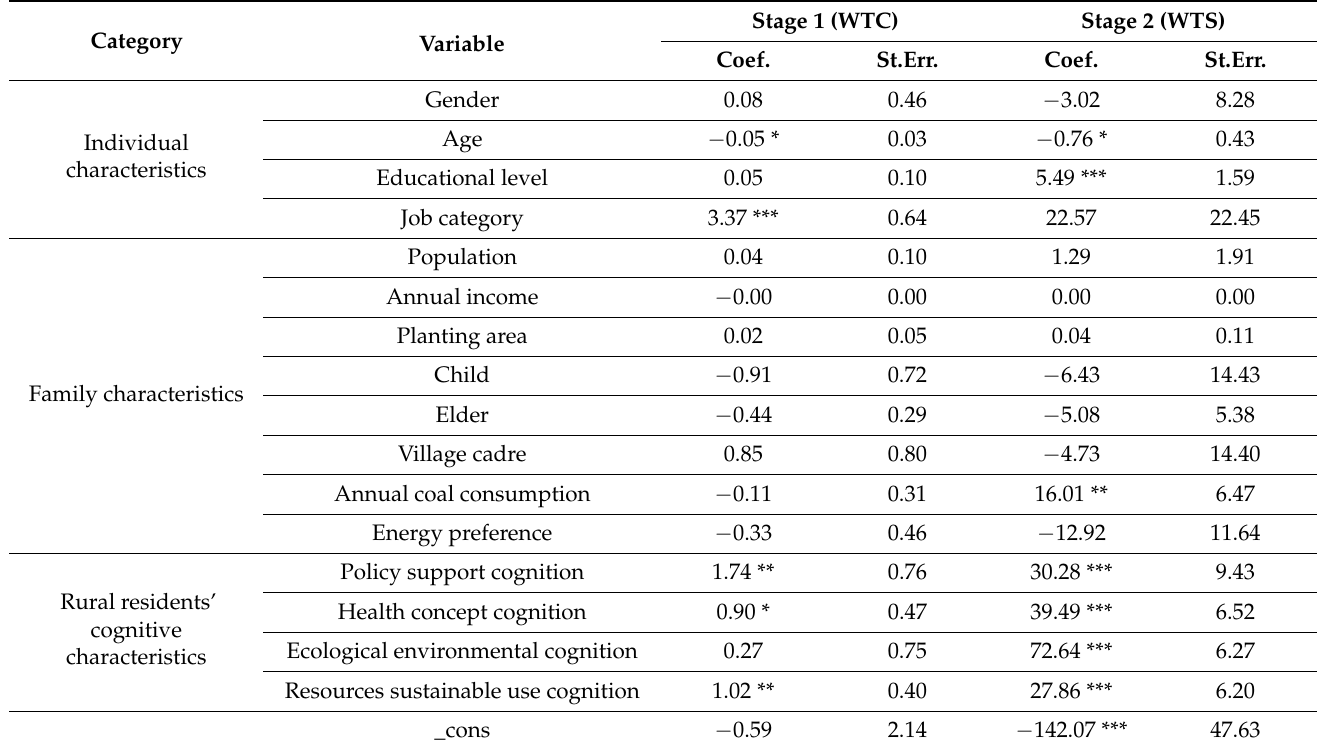
Table 3. Measurement